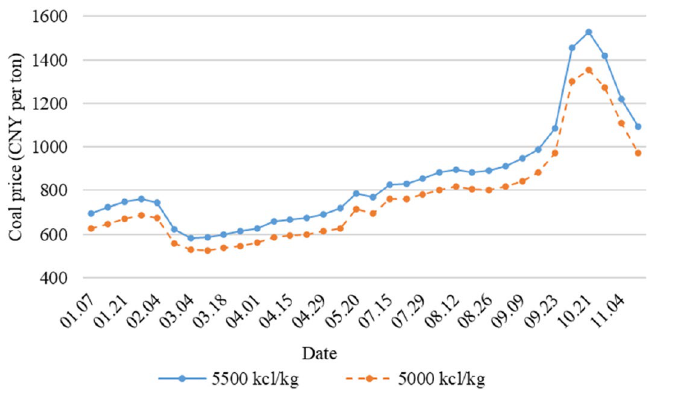
Figure 4. The trend of coal price.